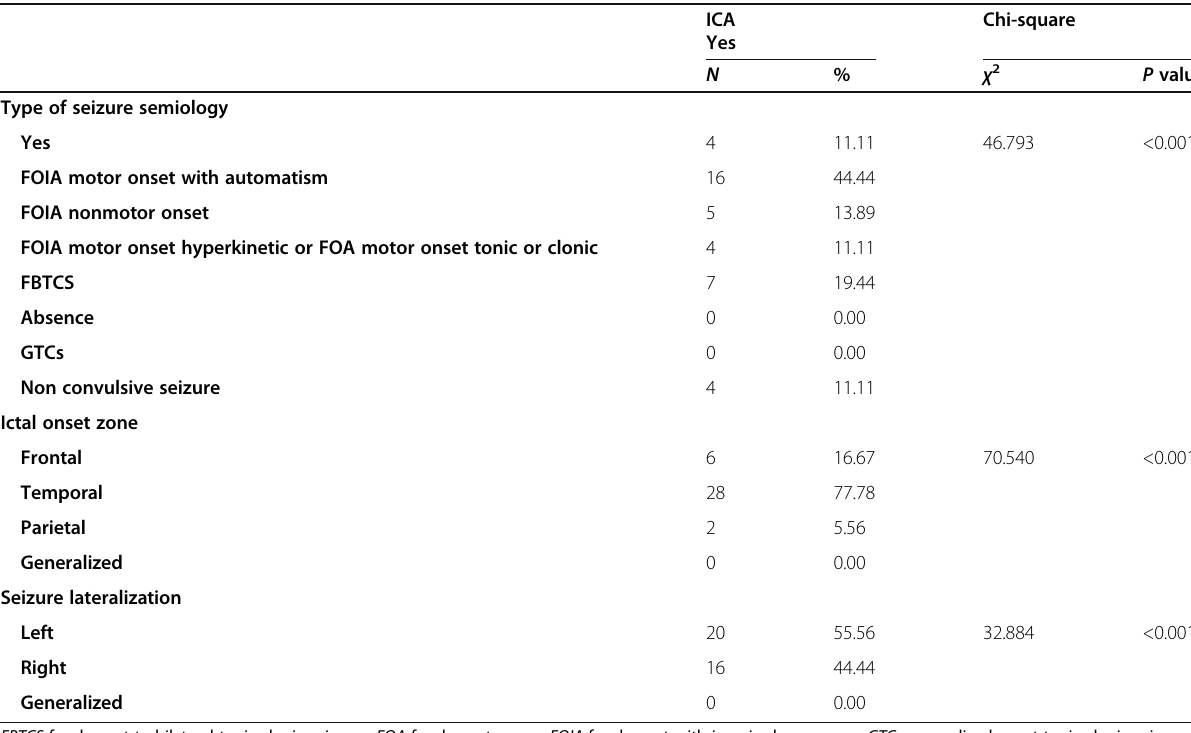
Table 1 Correlations between ICA occurrence and seizure semiology, lateralization, and ictal onset zone